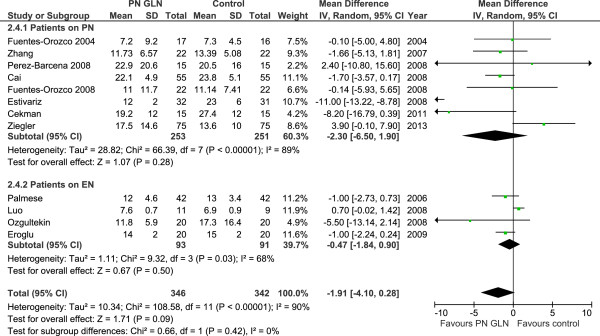
ICU length of stay.